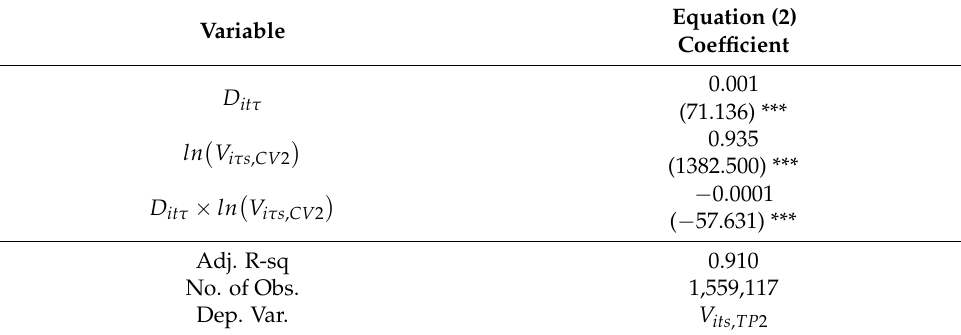
Table 5. Empirical results of the hedonic price